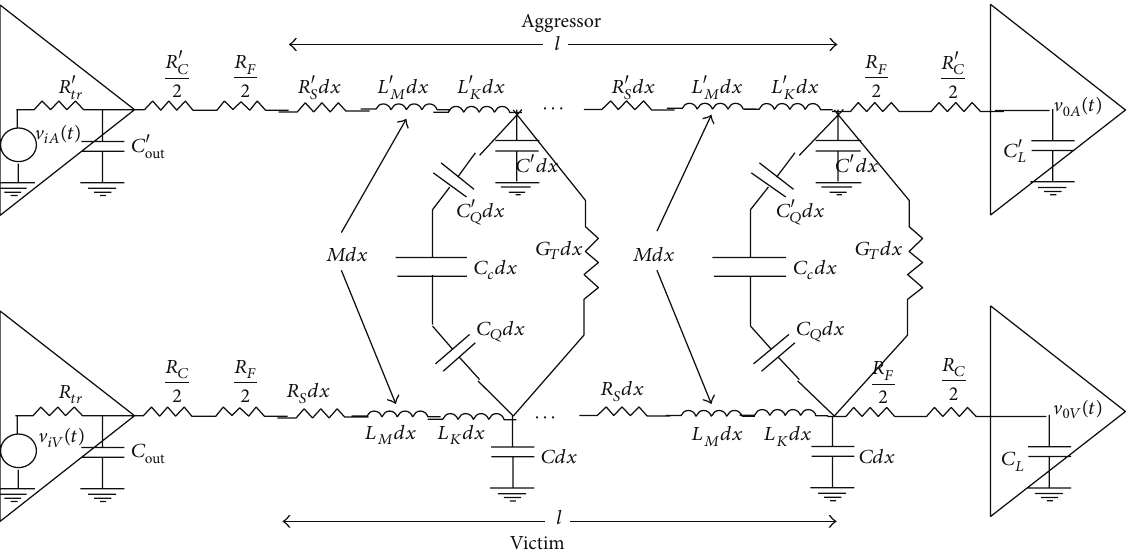
Figure 3: Equivalent circuit model for two coupled aggressor-victim CNT interconnects (the two neighboring shells in a MWCNT or the outer shells of two adjacent MWCNTs), with coupling effect